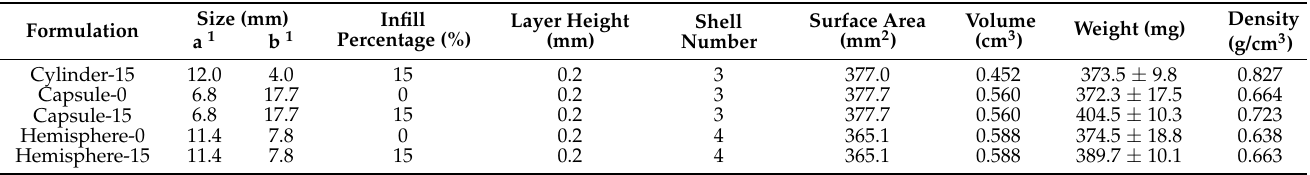
Figure 1. 3D digital models ( A ) cylinder; ( B ) capsule; ( C ) hemisphere) of the FDM 3D-printed formulations. Table 1. The parameters of the FDM 3D-printed formulations.